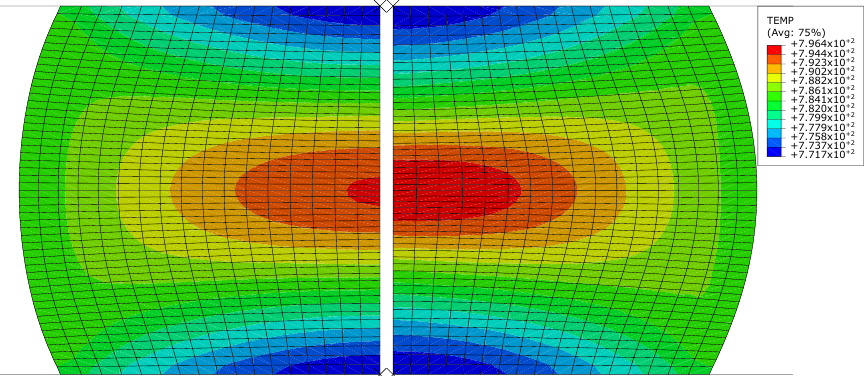
Figure 9. Temperature T contourplot for the compression of a cylinder using the 3-7-4-1 ( left side ) and the 3-15-7-1 ( right side ) ANN flow